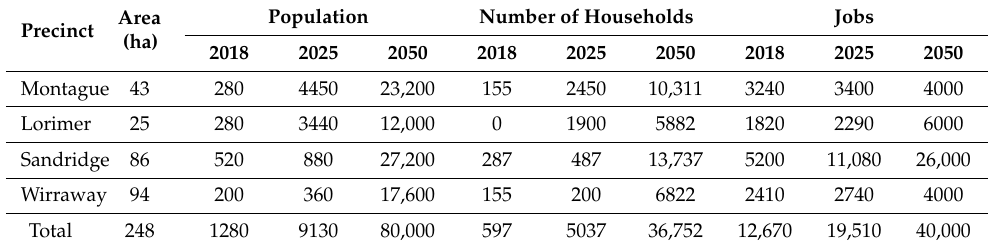
Table 4. The projection of population growth in FB’s residential precincts